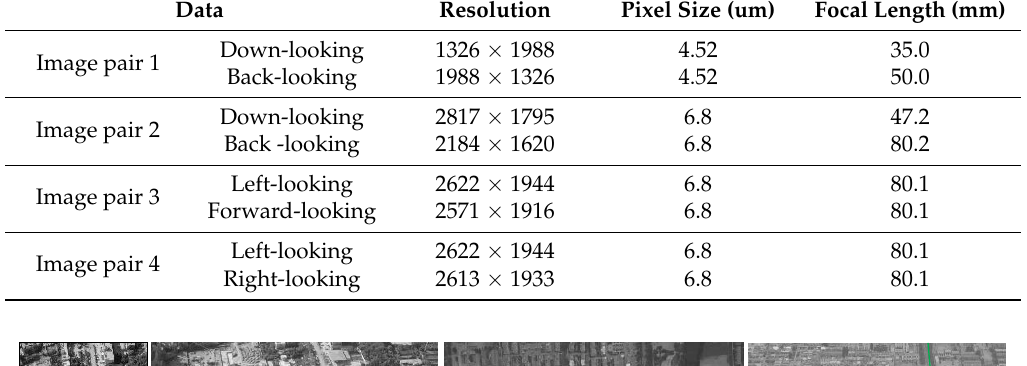
Table 2. Parameters of the four groups of data.